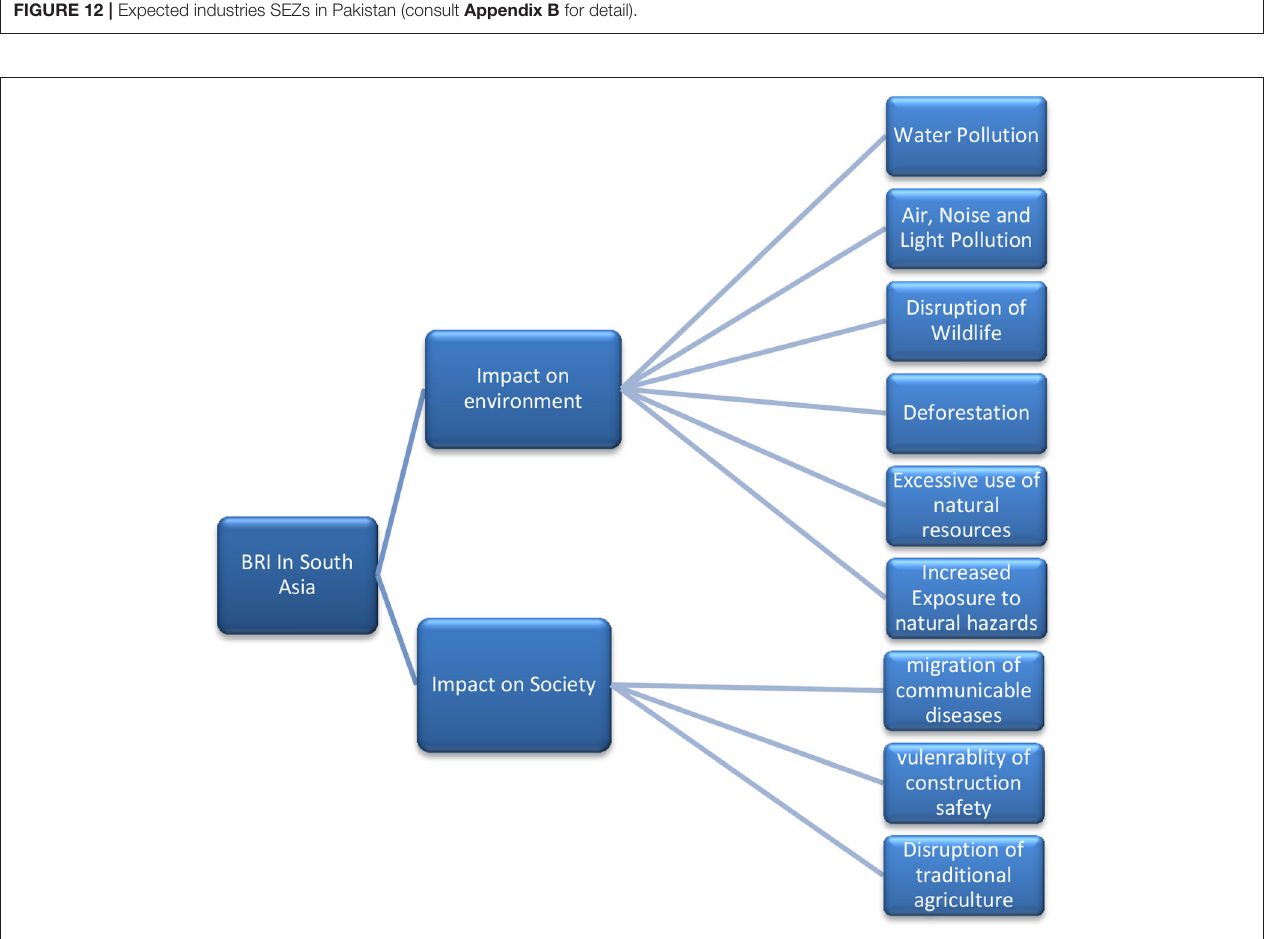
FIGURE 13 | Conceptual representations of How BRI in South Asia can affect the society and environment by heavy constructions and repair of roads, lines, excavations, wastes, building erections, air ports, and sea port constructions.